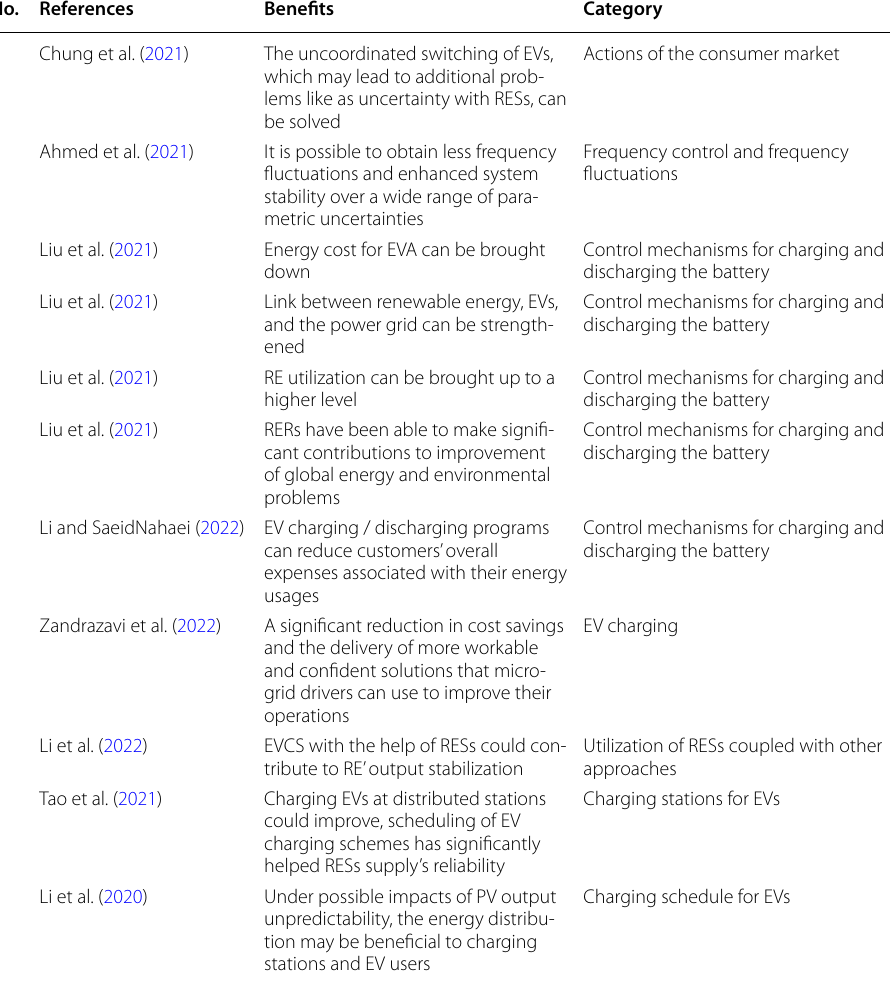
Table 3 A list of benefits retrieved from the reviewed literature No.